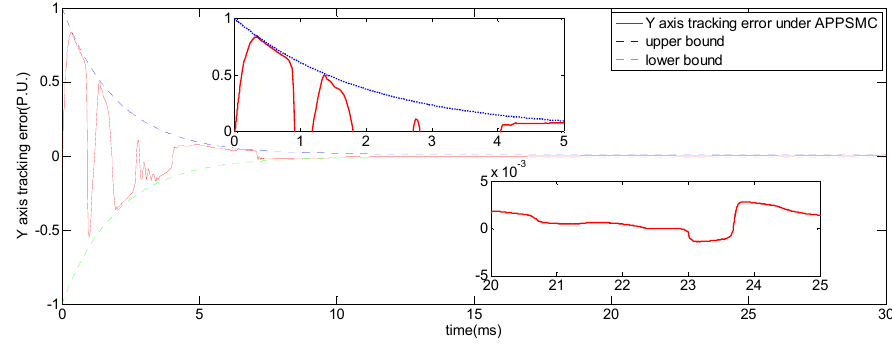
Figure 13. Y axis tracking error under low frequency noise.